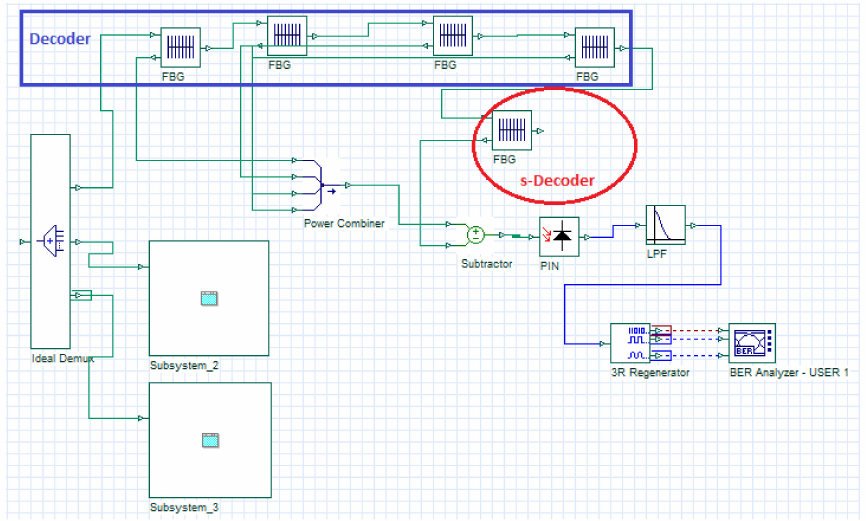
Figure 3. Transmitter/receiver of three users using DPS code with SPD detection